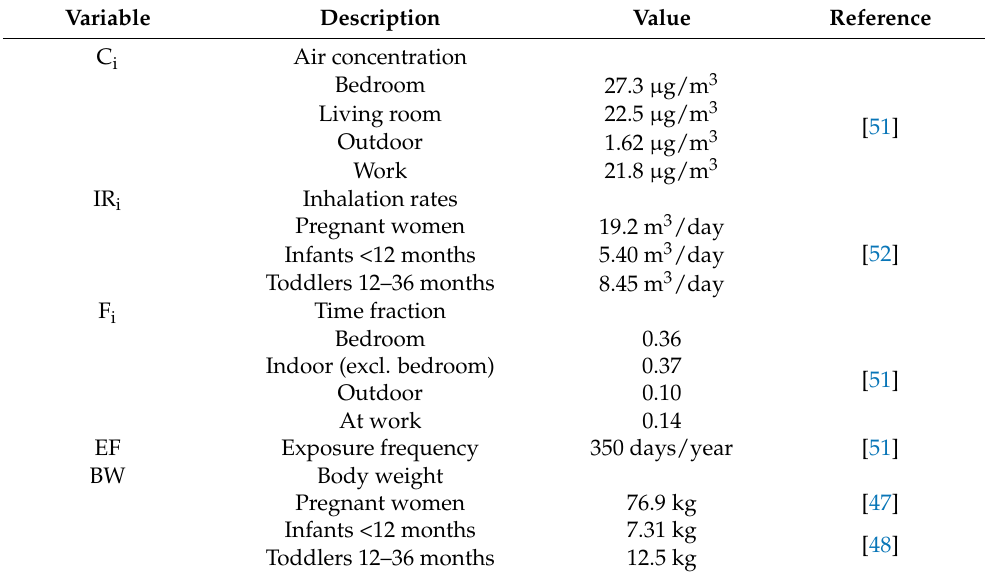
Table 2. Parameters used to assess inhalation exposure.